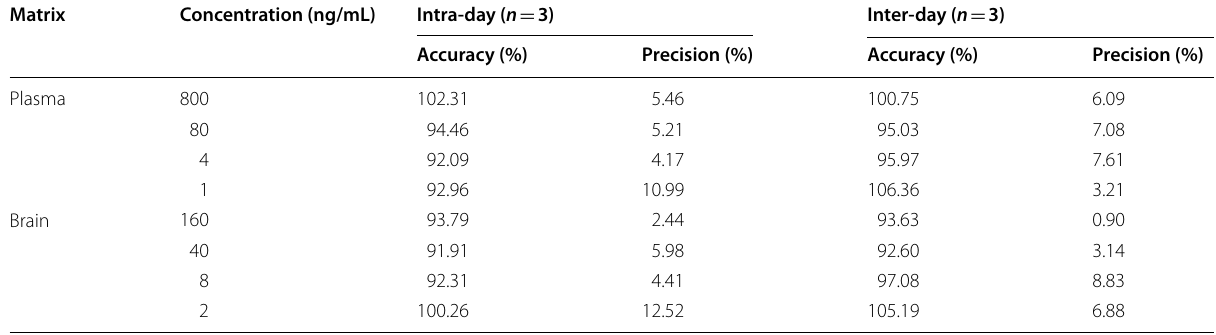
Table 2 Intra- and inter-day accuracy and precision of liraglutide analysis in the rat plasma and brain tissue Matrix Concentration (ng/mL) Intra-day ( n